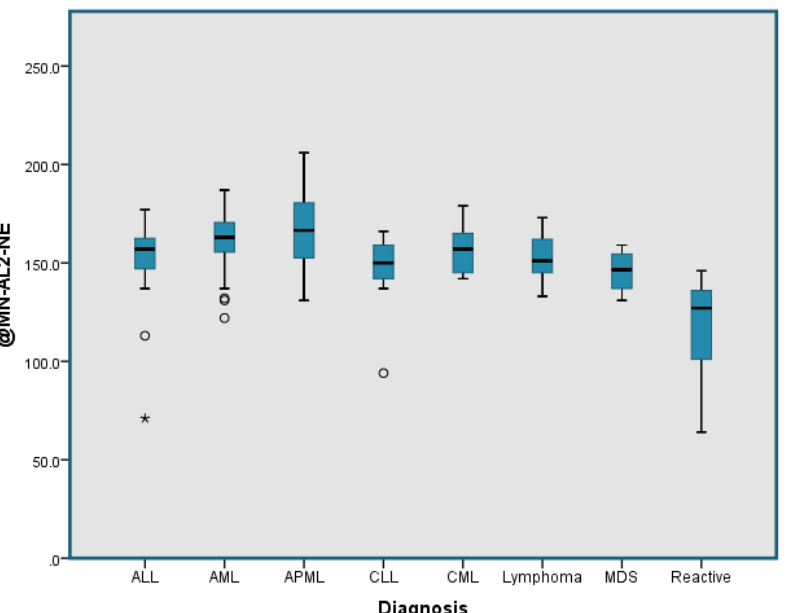
Figure 6. Box and whisker plot for the MN-AL2-NE parameter depicting subtypes of the neoplastic group (ALL, AML, APML, CLL, CML, lymphoma, MDS) versus the reactive group. There was an outlier marked as “*” in the ALL group.